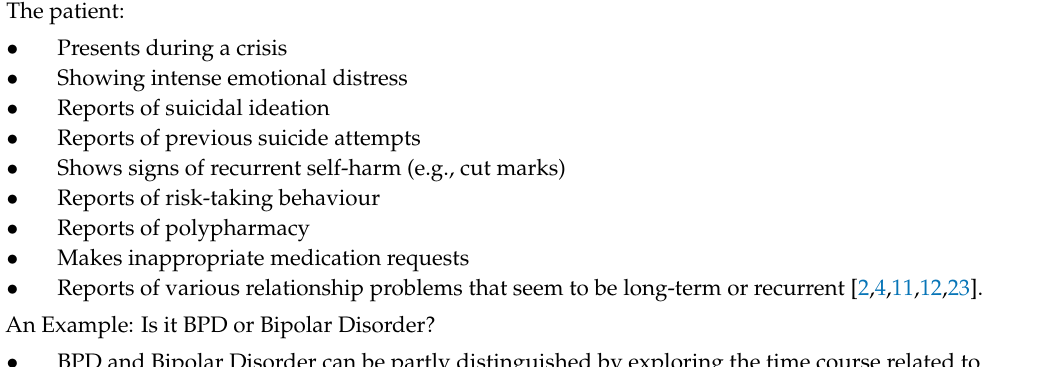
Table 2. Clues to Making a BPD